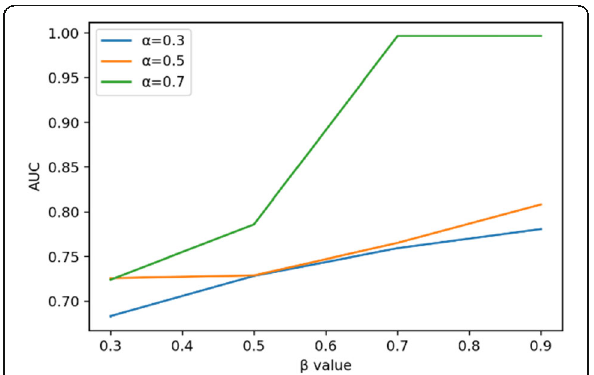
Fig. 12 The different parameters are employed in the function WJC TKA , and λ = 0.3 to obtain AUC values. α = 0.3, α = 0.5, α =